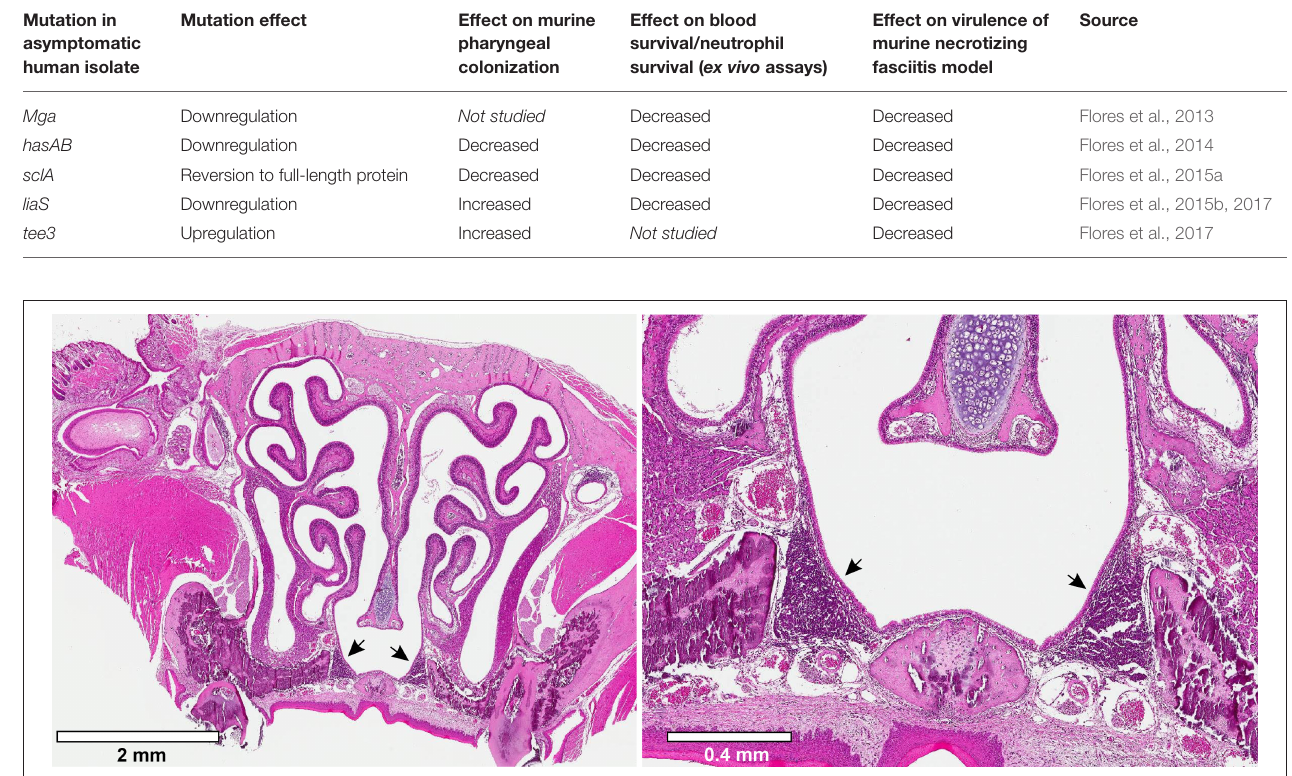
FIGURE 1 | Murine Nasal-associated Lymphoid Tissue (NALT). Transverse cross-sections through the nasal cavity approximately were obtained approximately half-way through the nasal cavity. The tissue was fixed and stained with hematoxylin and eosin. Arrowheads indicate the bilateral murine